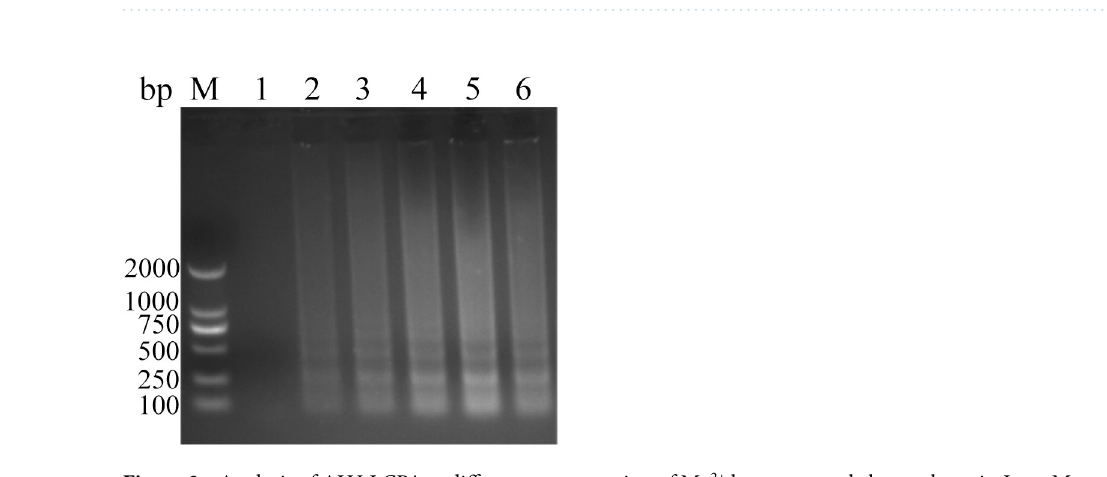
Table 1. Different primer concentration combinations.